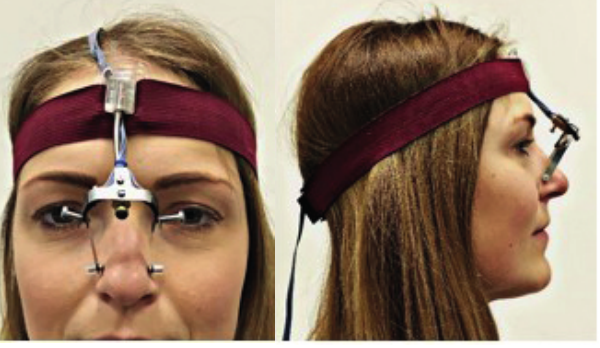
Figure 2. Device in situ fixed on a head-band.